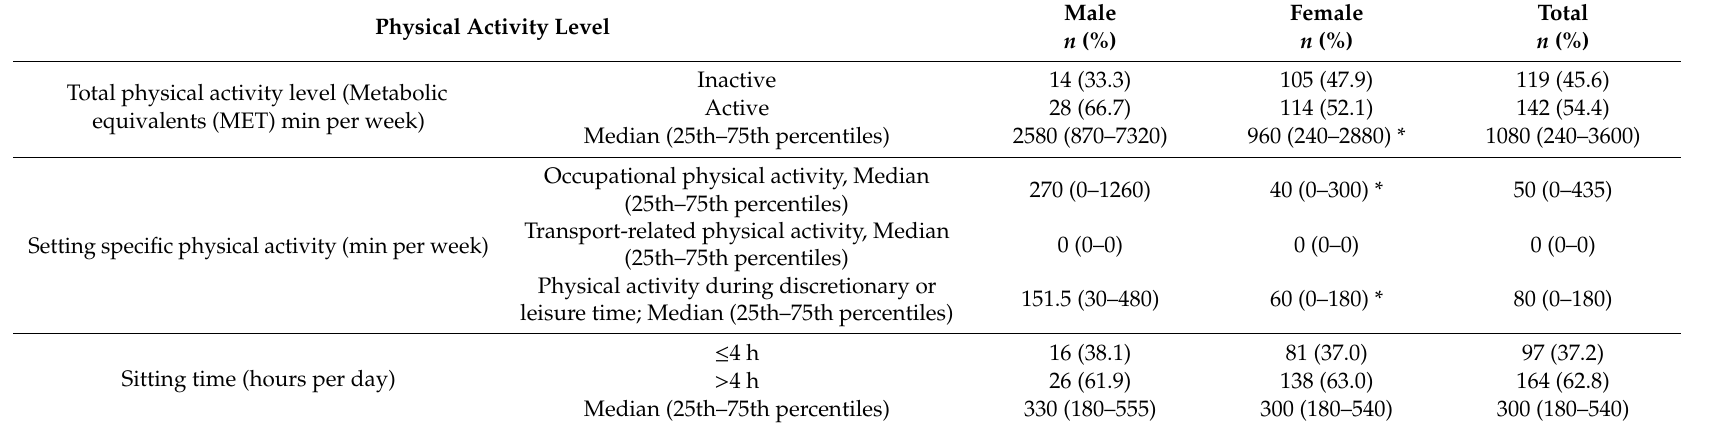
Table 1. Physical activity level and sedentary behaviours among the primary healthcare